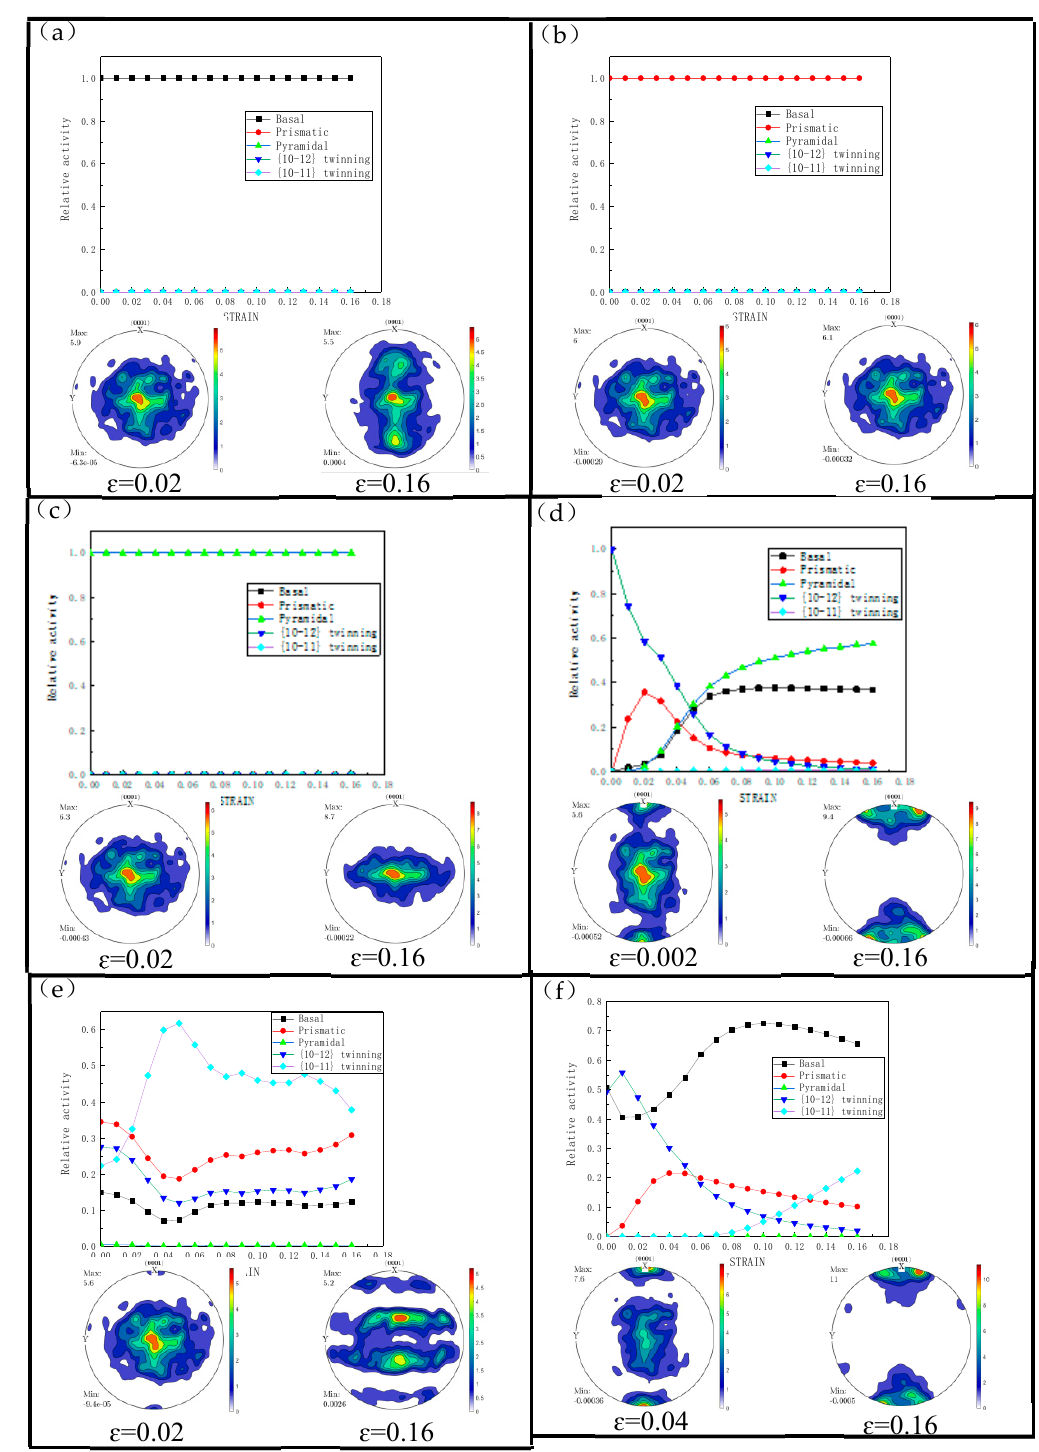
Figure 8 Optical microscope images of compression along 45ED (a) 0.01, (b) 0.05, (c) 0.15, and PED 21 (d) 0.01 (e) 0.05 (f) 0.11.